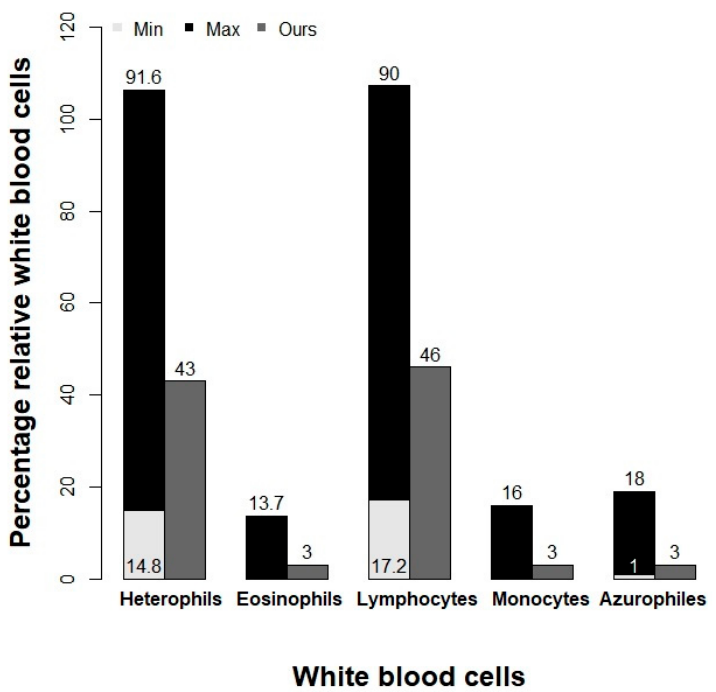
Figure 7. Comparison between the percentages relative to white cells in the blood counts for the loggerhead turtles ( Caretta caretta ) (ours) and the minimum and maximum ranges published by Yang et al.